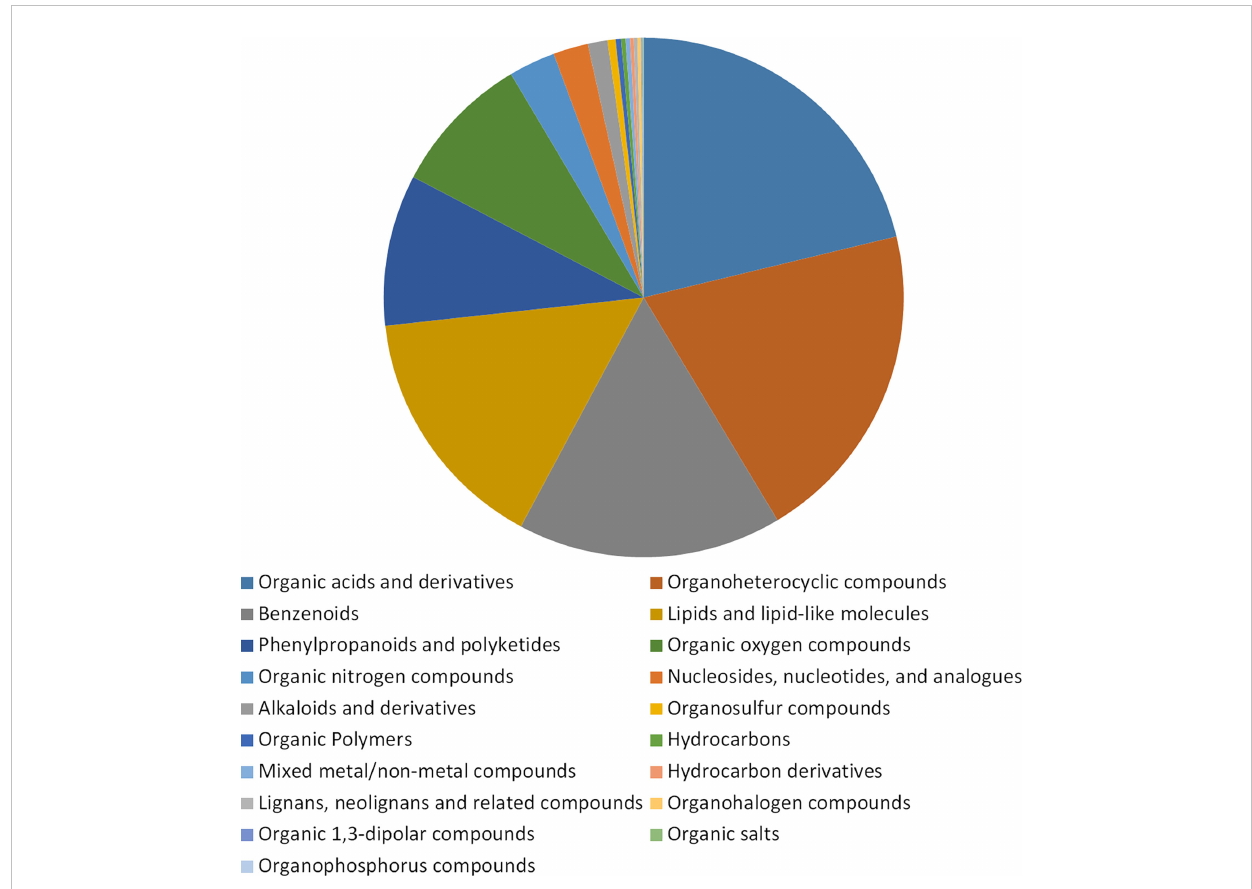
FIGURE 3 Statistical description of metabolic analysis of buckwheat on Cd response. Classi fi cation of the 1798 known identi fi ed metabolites in non-targeted metabolome analysis. The ratio of the detected metabolites to the total metabolites in the pie chart. Blocks with different colors indicate different supertypes of metabolite values, and different types are arranged in alphabetical order of